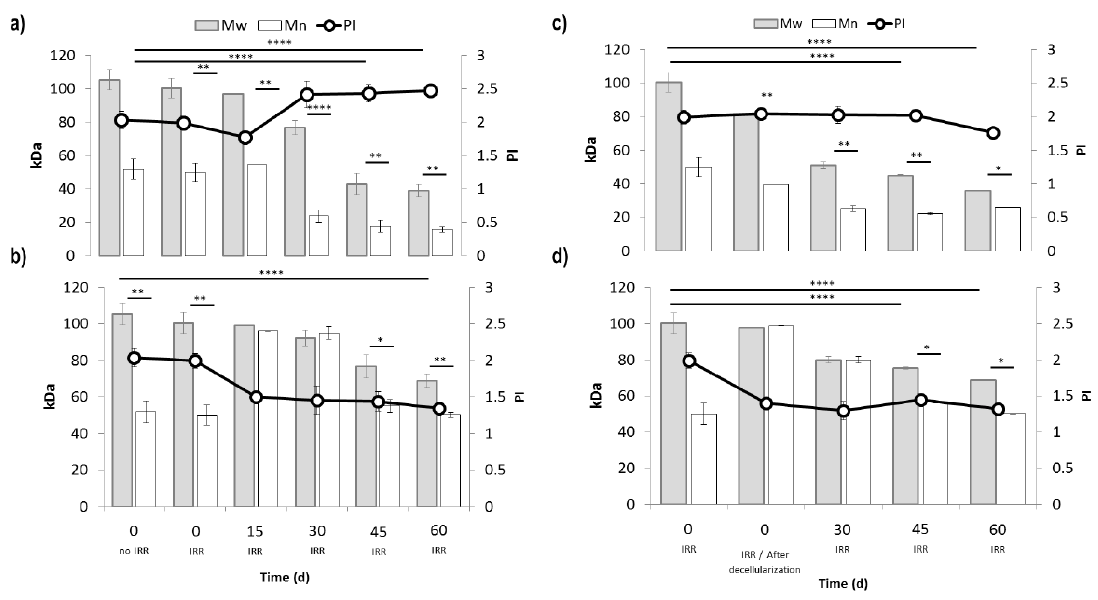
Figure 4. Changes of Mw, Mn, and PI: ( a ) TIP-Fs and ( b ) EL-Ms incubated in Modified Eagle Medium Low Glucose (DMEM-LG) at 37 ◦ C for 15, 30, 46, and 60 days, ( c ) TIP-Fs and ( d ) EL-Ms incubated in Artificial Saliva Solution (ASS) at 37 ◦ C for 30, 45, and 60 days. All samples have been incubated in ASS after incubation with Mesenchymal Stem Cells (MSCs) and decellularization. All Mw, Mn, and PI data have been compared with the corresponding sample non-irradiated and irradiated at time zero. A probability value less than 0.05 (* p < 0.05) was defined to be significant and 0.01 (** p < 0.01), 0.0001 (**** p < 0.0001) as highly significant.